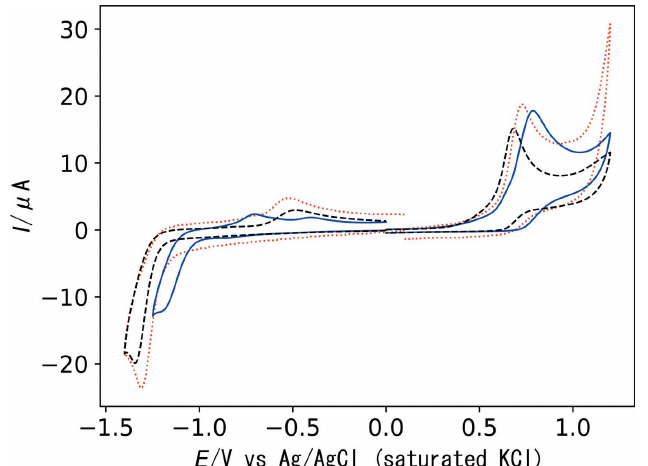
Figure 6 Cyclic voltammograms of complexes 1 (0.5 m M , red dotted line), 2 (0.5 m M , blue solid line), and blank solution (black dashed line) in 0.1 M acetate buffer at pH 4.6 containing 0.10 M KNO 3 : scan rate, 0.1 V s (cid:5) 1 ; working electrode, glassy carbon; auxiliary electrode, platinum wire; reference electrode, Ag/AgCl/saturated